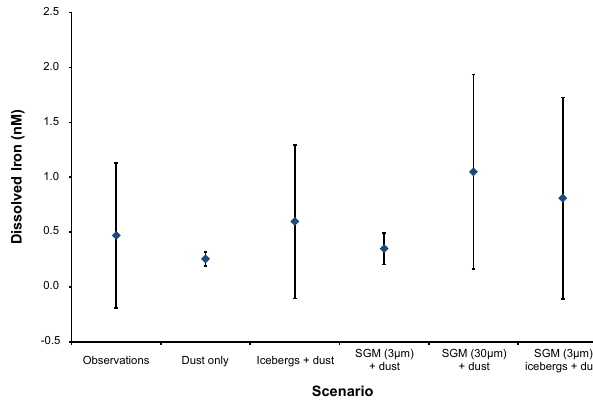
Figure 3. Summary statistics (mean and standard deviation) for observed (Tagliabue et al., 2012) and modelled surface ocean (0– 100m) iron concentrations, illustrating the differences between the modelled